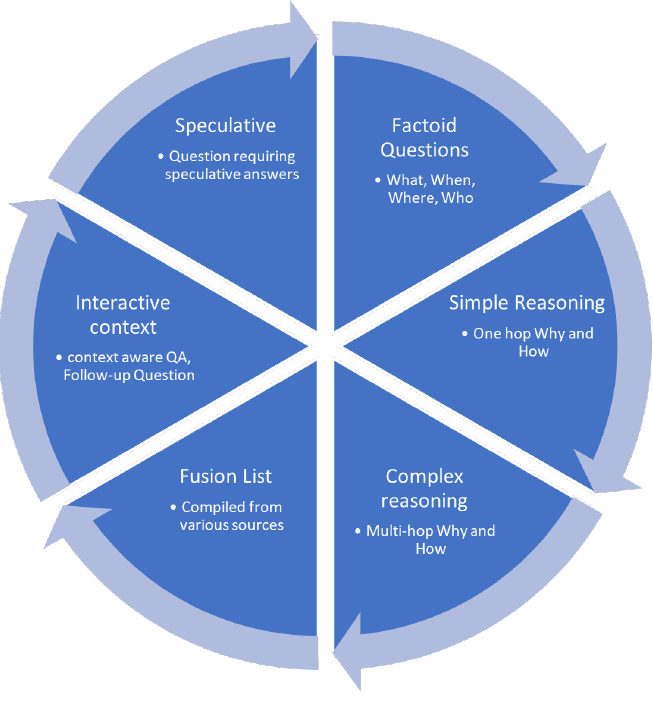
Figure 1. Types of Questions.